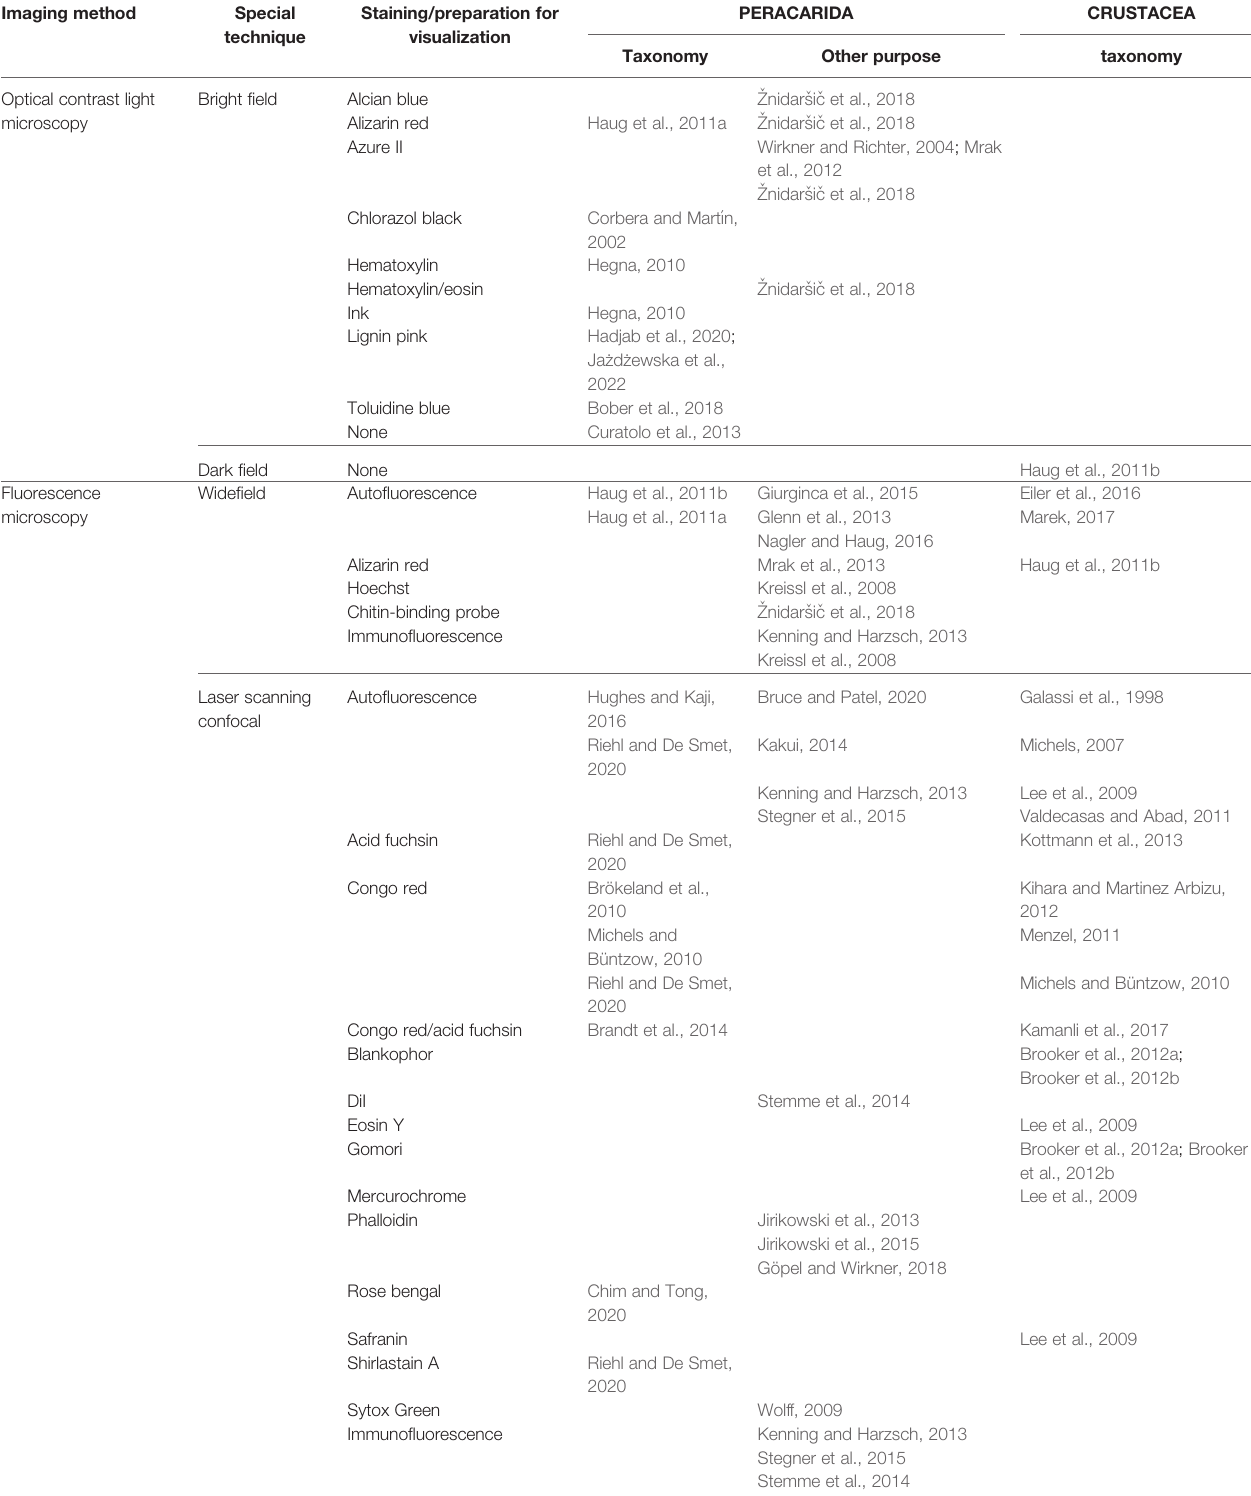
TABLE 3 | Selected examples of literature references where different imaging techniques were used to study the taxonomy of peracarids and other crustaceans or were applied to visualize peracarids for non-taxonomic purposes. Imaging